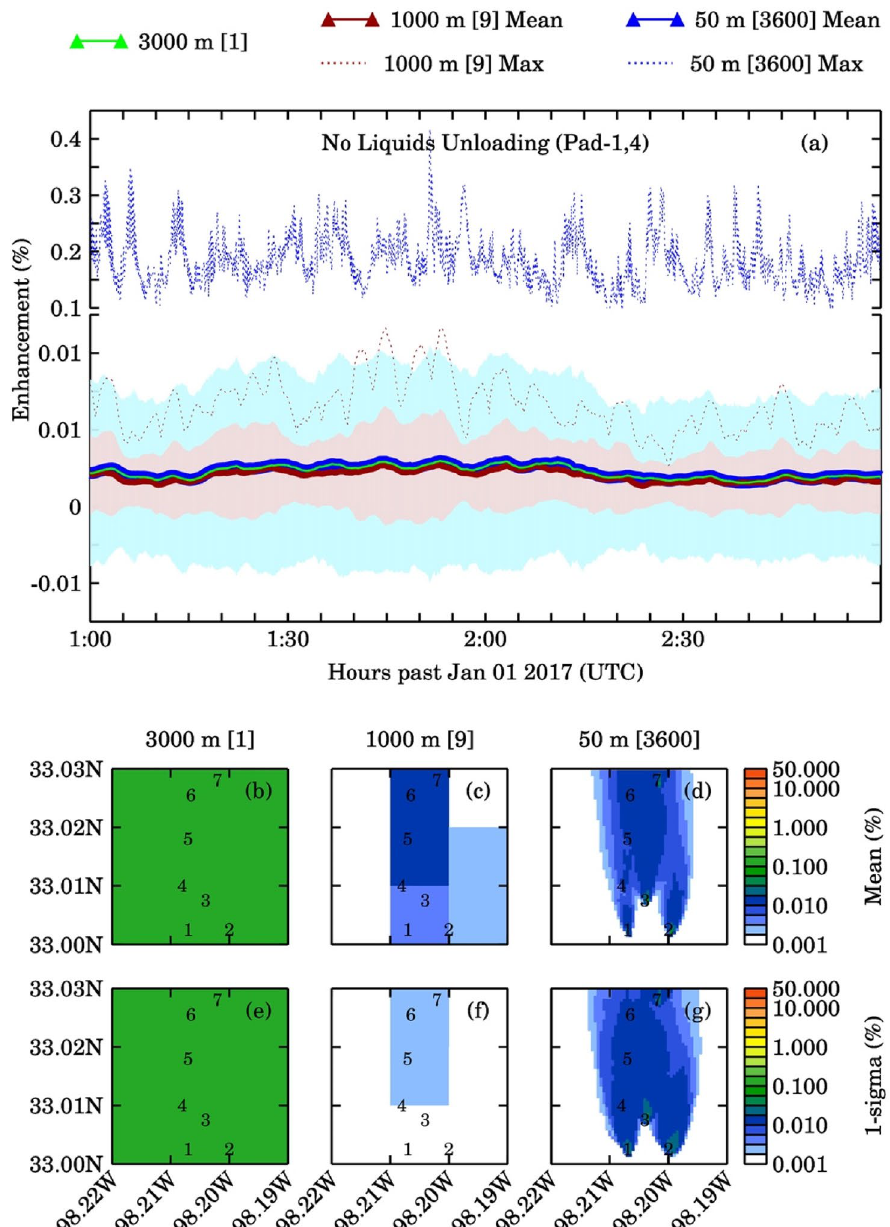
Figure 3. ( a ) Time series of percentage methane column enhancement with all emissions sources excluding the liquids unloading emissions from Pad-1 and 4 for three pseudo satellite pixels (there are 3600, 50 m pixels; 9, 1000 m pixels in one 3000 m pixel). Light green, dark red, and dark blue solid lines represent mean values and dotted lines represent maximum values over 3000 m, 1000 m and 50 m pixels, respectively. The plot also shows 1-sigma standard deviation as shaded area (light brown for 1000 m and light blue for 50 m pixels). Plots ( b – d ) represent the temporal averaged spatial distribution of column enhancements for three satellite pixels and plots ( e – g ) represent the 1-sigma variations to the mean column enhancements. The numbers mentioned in the square brackets are the number of pixels for that